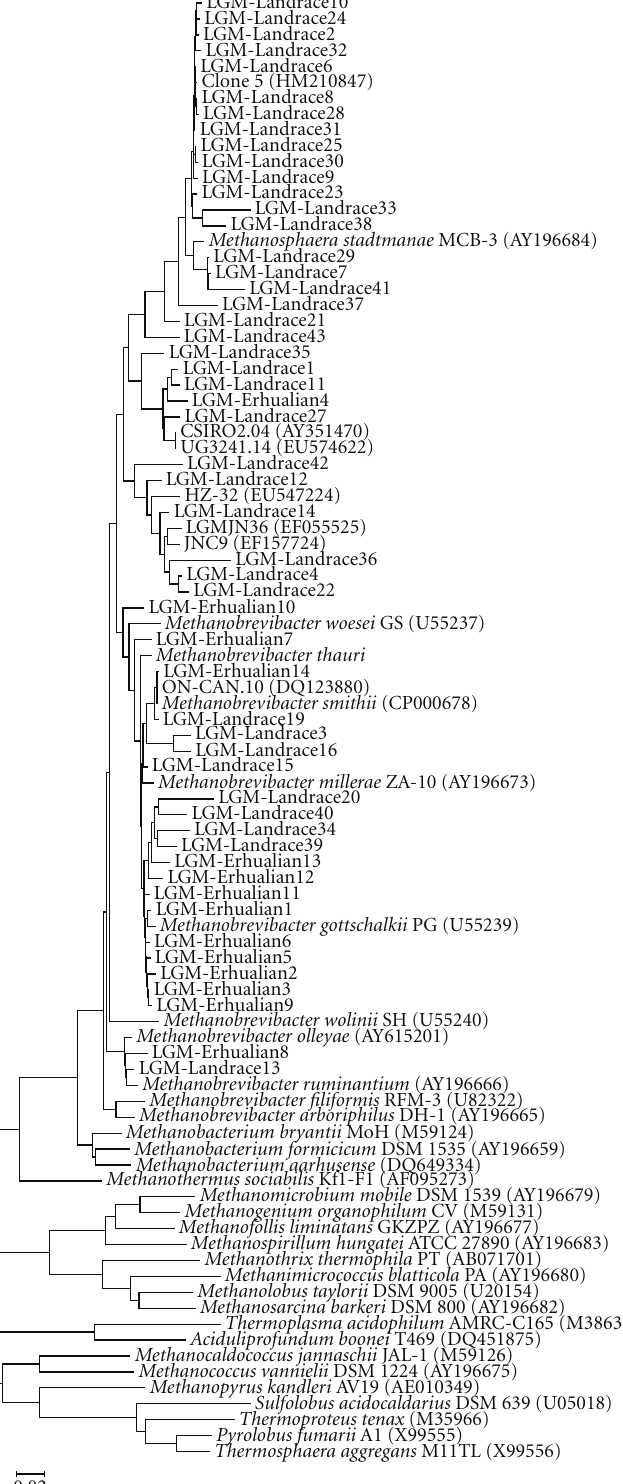
Figure 1: Phylogenetic relationship of archaeal 16S rRNA gene sequences retrieved from fecal samples of Erhualian and Landrace pigs. Evolutionary distances were calculated using the Neighbor-Joining method. The tree was bootstrap resampled 1000